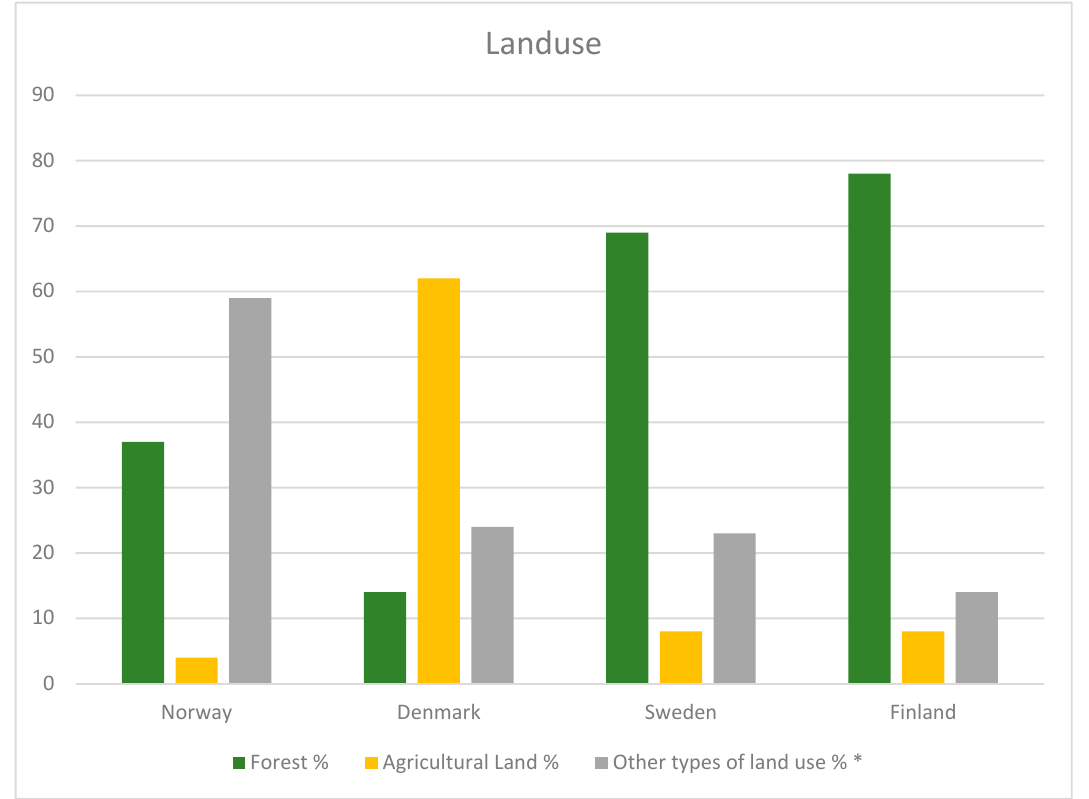
Figure 2. A bar diagram showing the distribution of forest, agricultural land, and other types of land use.